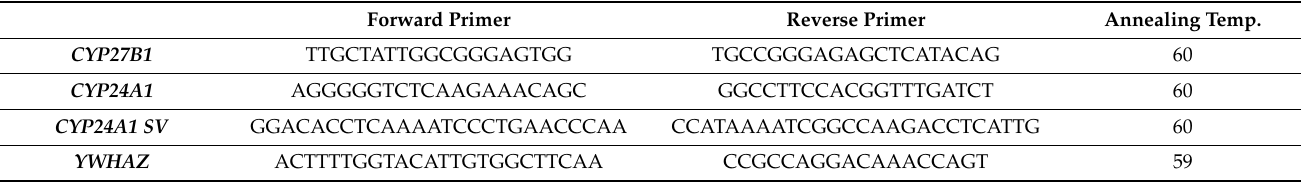
Table 3. Primers for